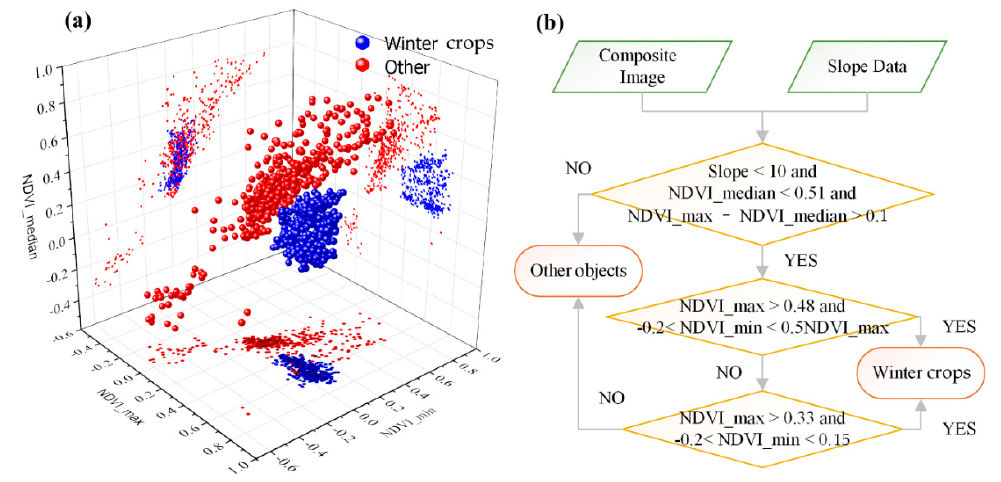
Figure 6. ( a ) Scatter diagram of winter crops and non-winter crops in the composite image. ( b ) Decision tree model for mapping winter crops. tree model for mapping winter